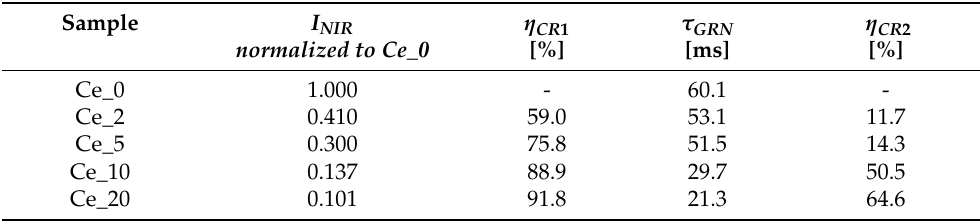
Table 1. Results of the intensity measurements of Ho 3+ NIR emission, and of the calculations related to Ho 3+ GRN emission lifetime and Ce 3+ -mediated CR efficiency for the investigated Ln 3+ -doped NaBiF 4